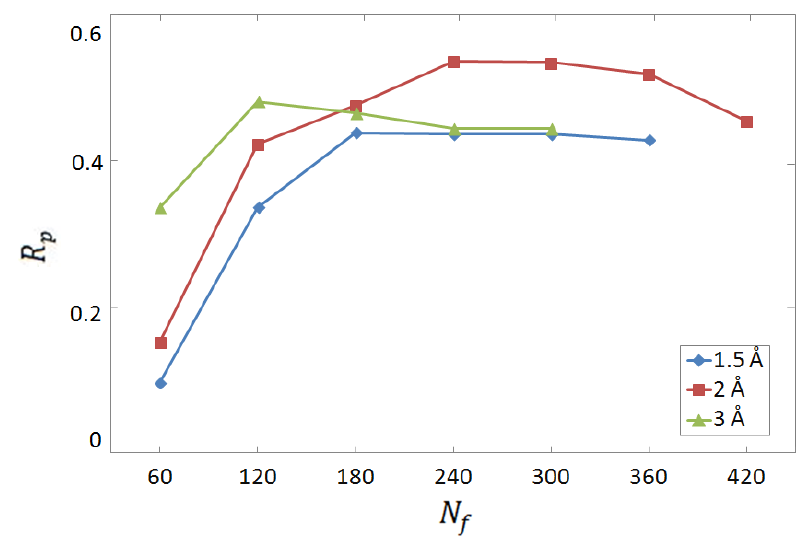
Figure 1. Pearson correlation coefficient R p for the predictions of binding affinity provided by the FCNN SF, as a function of the number of descriptors N f . This FCNN SFis trained and tested on the experimental database. The protein–ligand complex structure is represented by atomic-pair counts within a variable number of distance intervals. The three datasets correspond to different interval widths. Sixty pairs of atomic species are considered, including pairs with hydrogen.